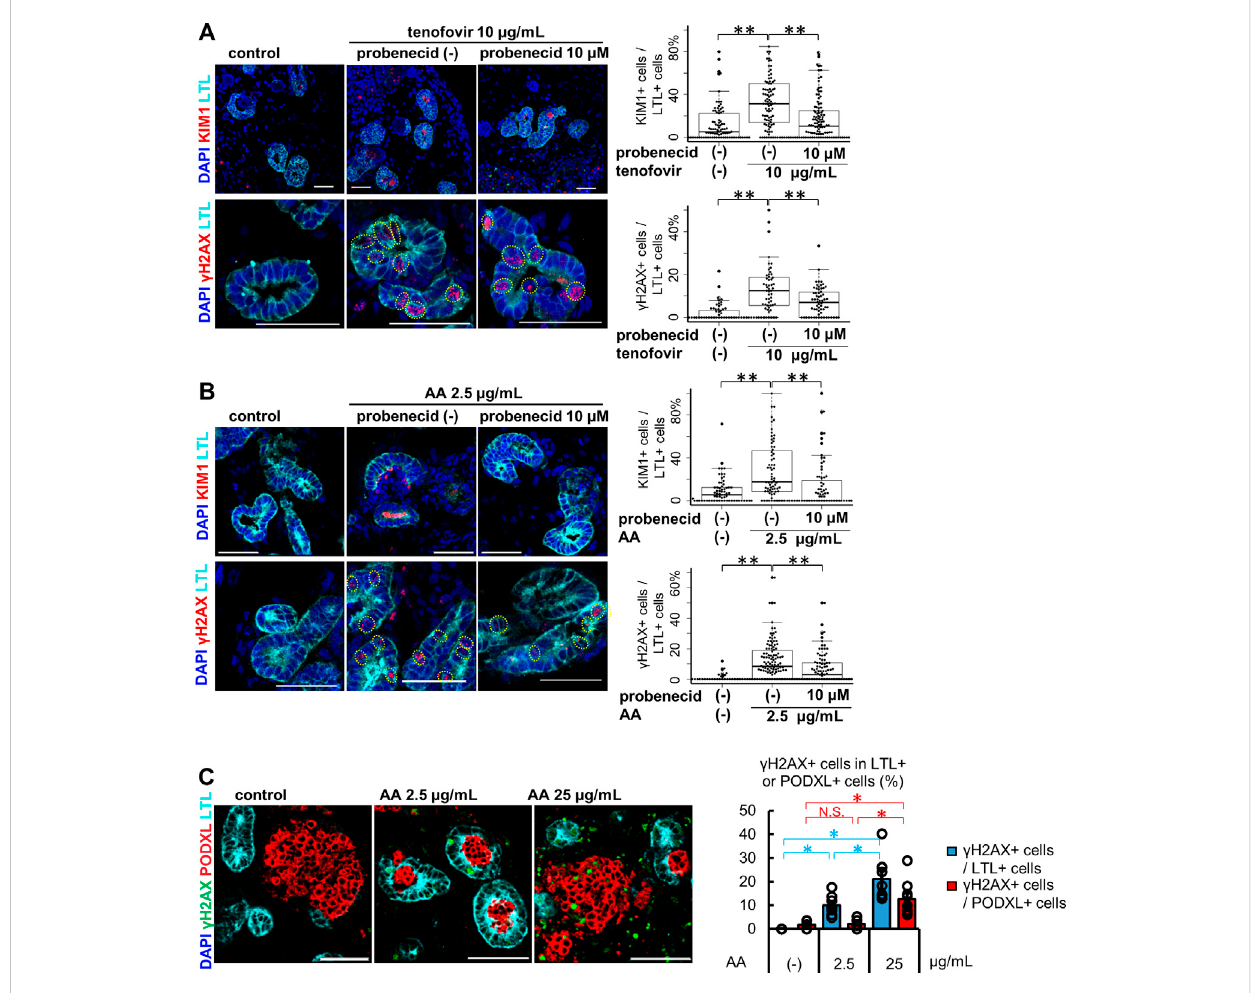
FIGURE 3 Tubule-speci fi cinjury in kidney organoids underthe treatment of OAT1/3 mediated nephrotoxicants. (A) RepresentativeIF images of KIM1 (red) and γ H2AX (red) in the organoids (day53) treated with 10 μ g/mL tenofovir for 7 days. Probenecid ameliorated the KIM1 and γ H2AX increase caused by tenofovir. Experiments were repeated independently n = 3 times with similar results. **p < 0.01. Scale bar: 50 μ m. (B) Representative IF images of KIM1 (red) and γ H2AX (red) in the organoids (day 37) treated with 2.5 μ g/mL AA for 24 h. Probenecid attenuated AA-induced proximal tubule injury. Experimentswererepeatedindependently n =3timeswithsimilarresults. **p < 0.01.Scalebar:50 μ m. (C) IFof γ H2AXintheorganoidstreatedwithlower or higher doses (2.5 or 25 μ g/mL) of AA. *p < 0.05. Scale bar: 50 μ